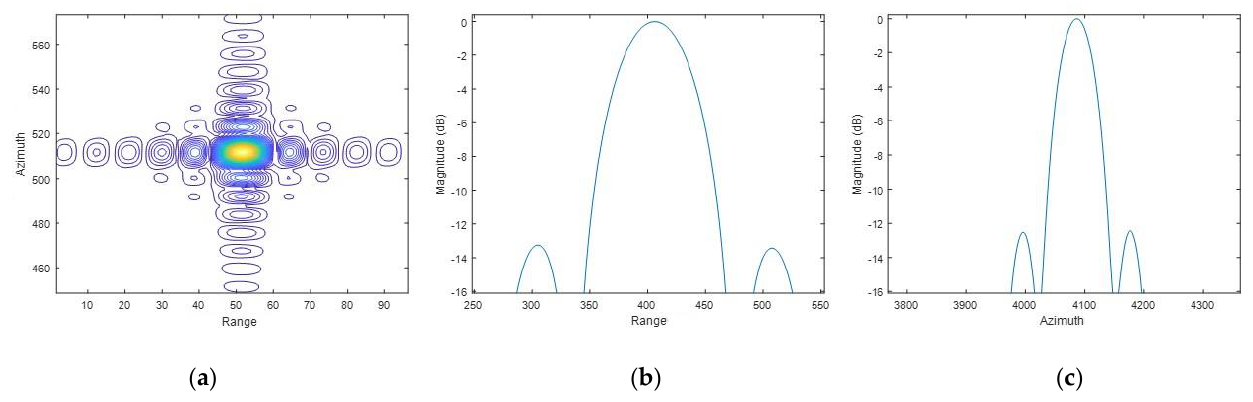
Figure 8. Refocused result of the moving target T3. ( a ) Impulse responses of T3. ( b ) Range profile of T3. ( c ) Azimuth profile of T3.